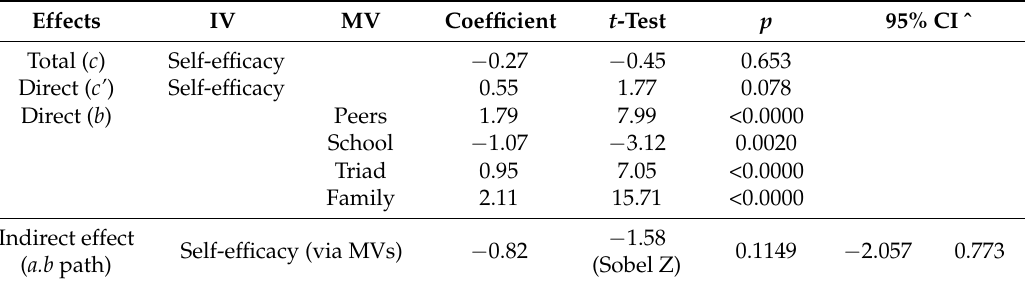
Table 8. Mediating analysis of contextual factors on the relationship between self-efficacy and violence of youth